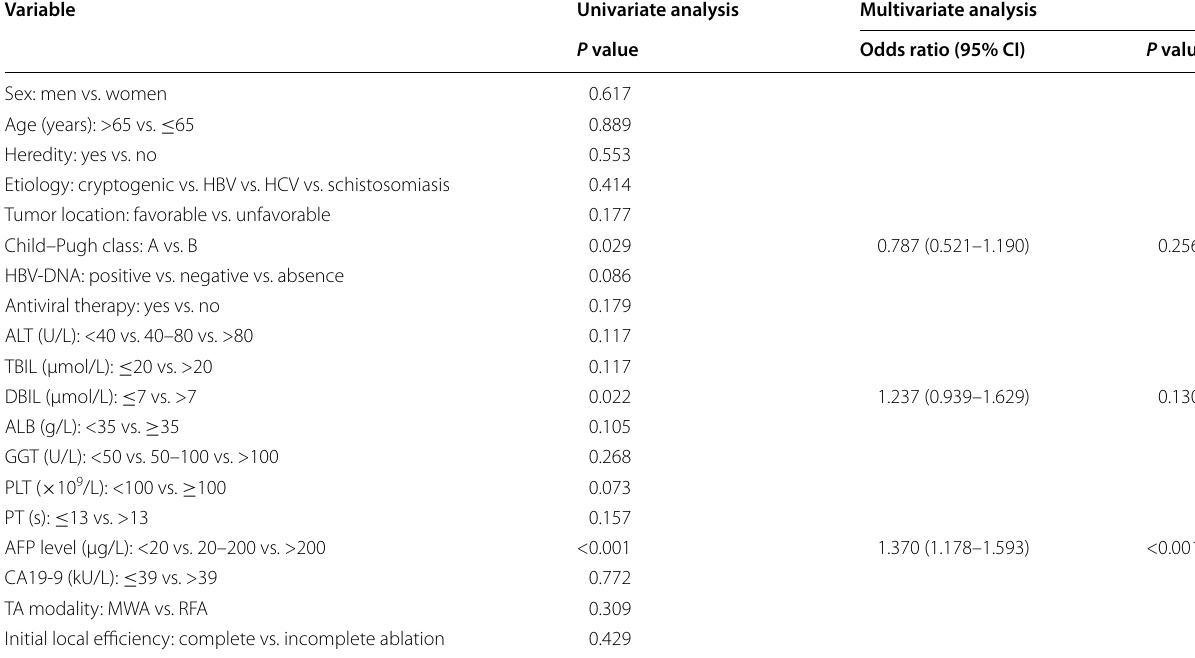
CI confidence interval, HBV hepatitis B virus, HCV hepatitis C virus, ALT alanine aminotransferase, TBIL total bilirubin, DBIL direct bilirubin, ALB albumin, GGT gamma- glutamyl transpeptidase, PLT platelet, PT prothrombin time, AFP alpha fetoprotein, TA thermal ablation, RFA radiofrequency ablation, MWA microwave